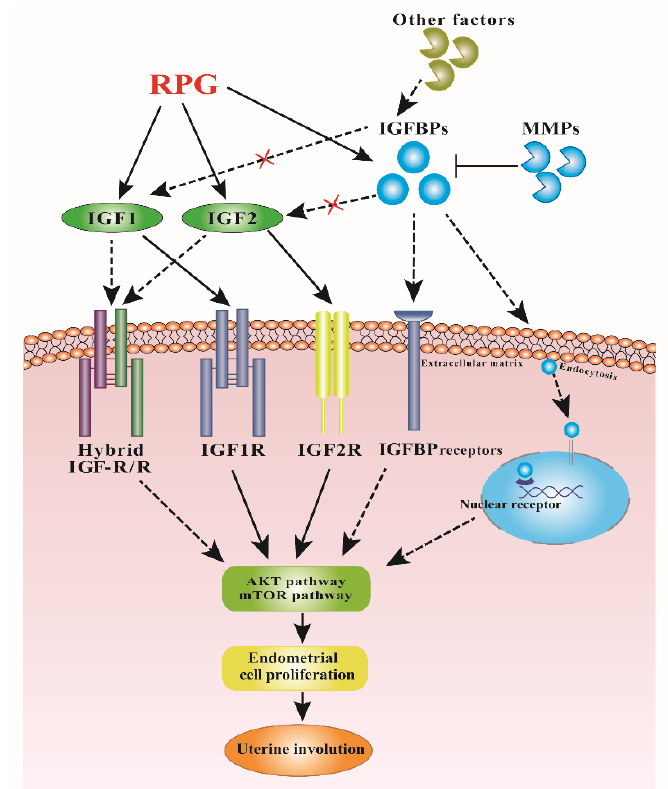
Figure 6. Proposed mechanism for RPG in regulating the uterine involution in post-natal dairy cows. The effect of RPG addition was mediated by both IGFs and mTOR/AKT signaling pathways. RPG addition might promote IGF1 and IGF2 binding to their respective receptors and enhance IGF-independent actions of IGFBPs, thereby activating the mTOR/AKT signaling pathway and accelerating the endometrial proliferation and repair. Each ligand displayed a specific binding affinity for the receptors: continuous arrows indicate high affinity, while dotted arrows and a red “X” indicates low affinity. The black dashed arrows are currently unknown.